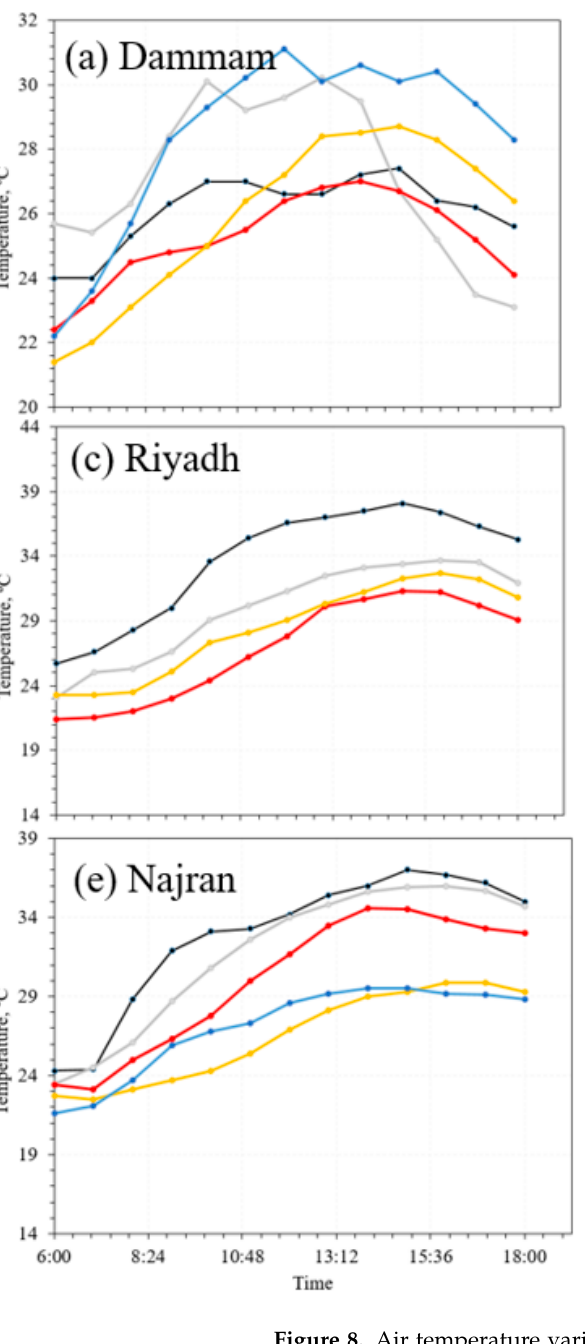
Figure 8. Air temperature variability (°C) over six Saudi cities ( a ) Dammam, ( b ) Hafar Al Batin, ( c ) Riyadh, ( d ) Jeddah, ( e ) Najran, and ( f ) Arar from 13 to 17 April 2021. No data are available for ( c ) Riyadh on 17 April 2021. No data are available for